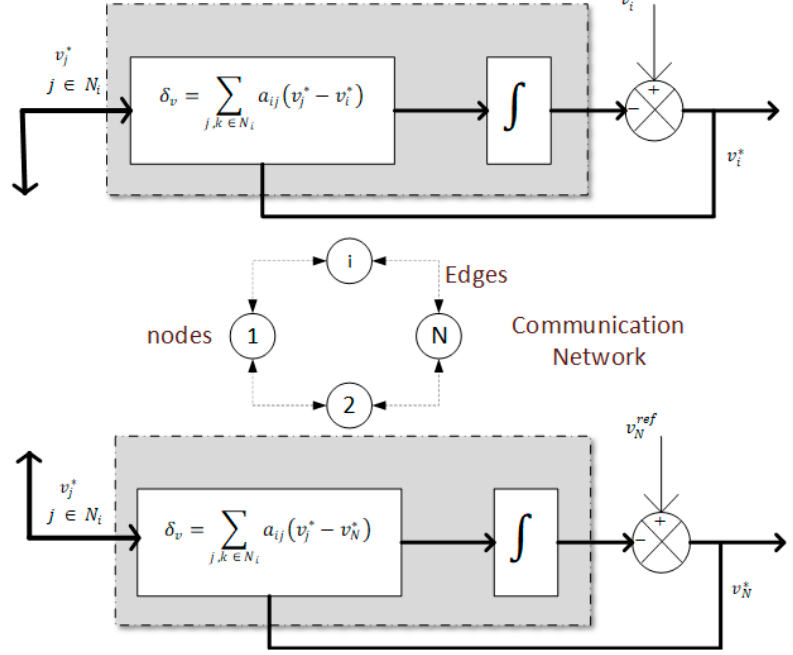
Figure 4. Voltage observer in the proposed secondary control.